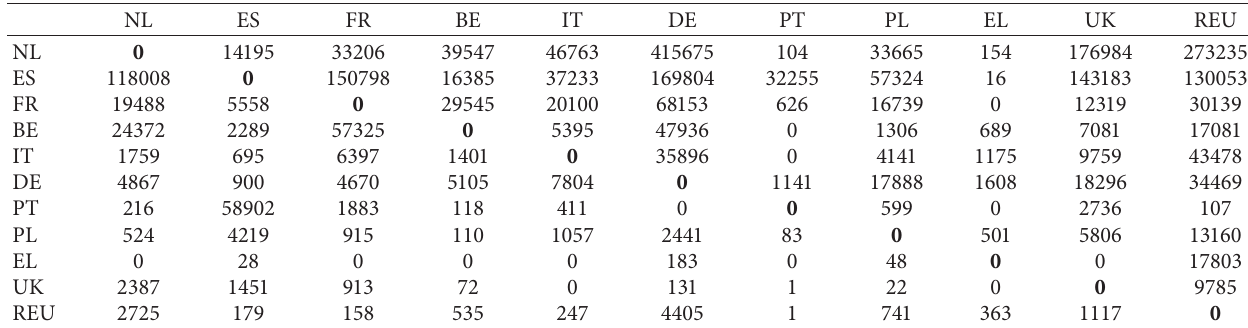
Table 5: Matrix of trade transactions 2017.